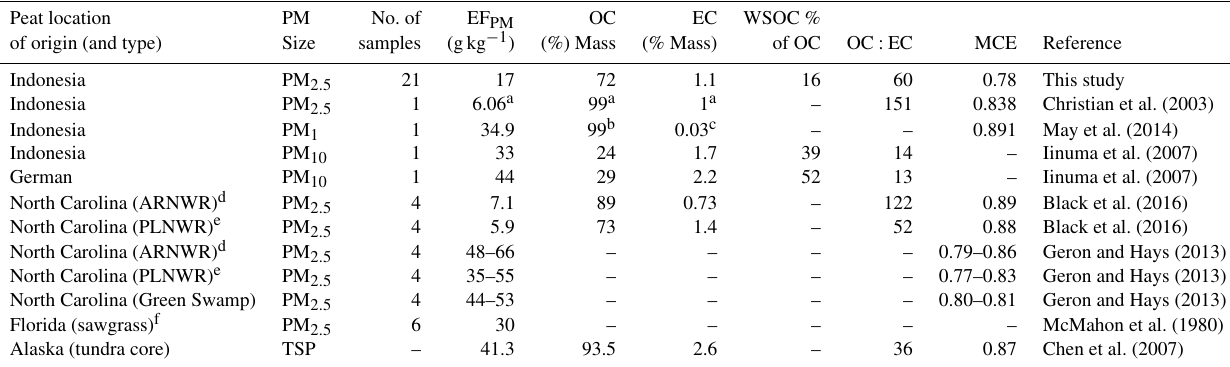
Table 1. Comparison of the averaged in situ Indonesian peat emission data to prior laboratory studies of peat combustion. Peat location